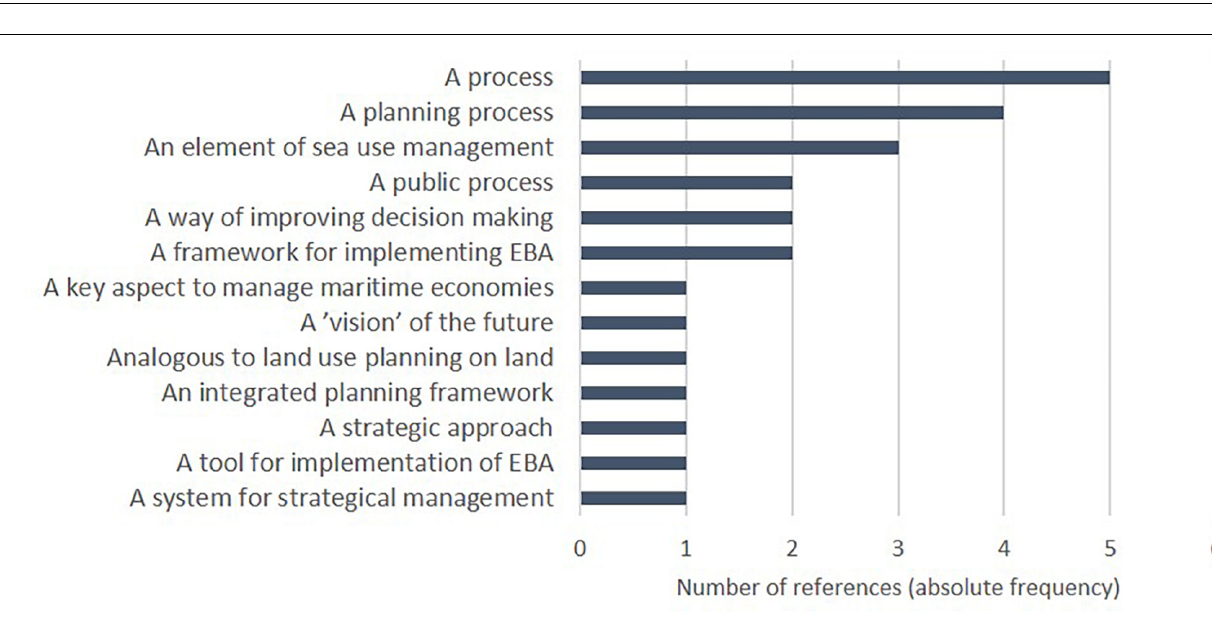
Frontiers in Marine Science |